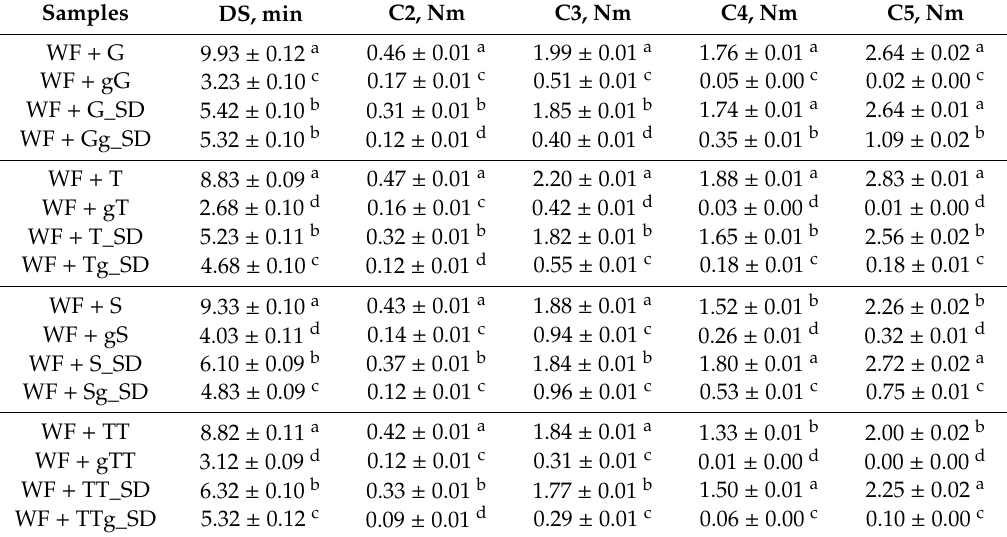
Table 2. E ff ect of the addition of flours from raw (G, T, S and TT) or germinated grains (gG, gT, gS and gTT) and of corresponding sourdough samples (G_SD, T_SD, S_SD and TT_SD prepared out of G, T, S and TT flours, and gG_SD, gT_SD, gS_SD and gTT_SD prepared out of gG, gT, gS and gTT flours). On the thermo-mechanical properties of the white wheat flour (WF) dough. Measurements were performed in triplicate by means of Mixolab using the Chopin + protocol. Samples DS, min C2, Nm C3, Nm C4, Nm C5, Nm WF +